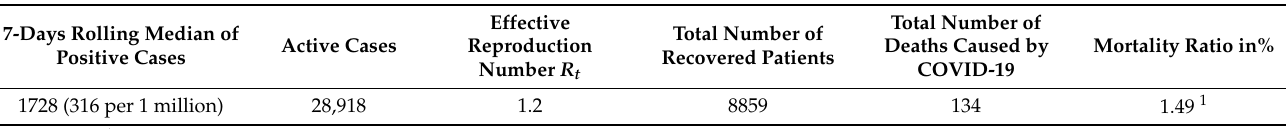
Table 1. Official measures are taken by the Ministry of Health of the Slovak Republic related to the day before the trial testing (22 October 2020)